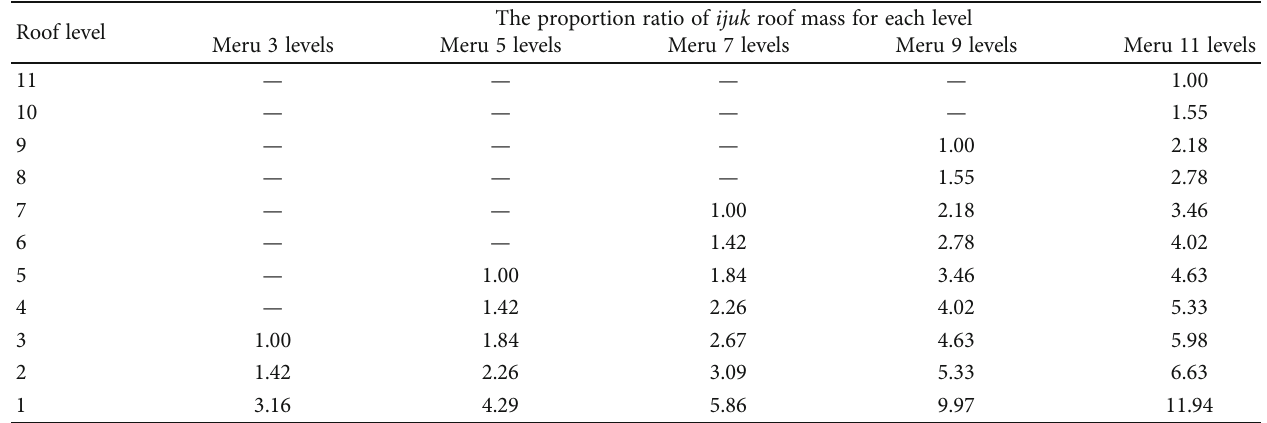
Table 4: Ijuk mass ratio of number of roof levels 3 to